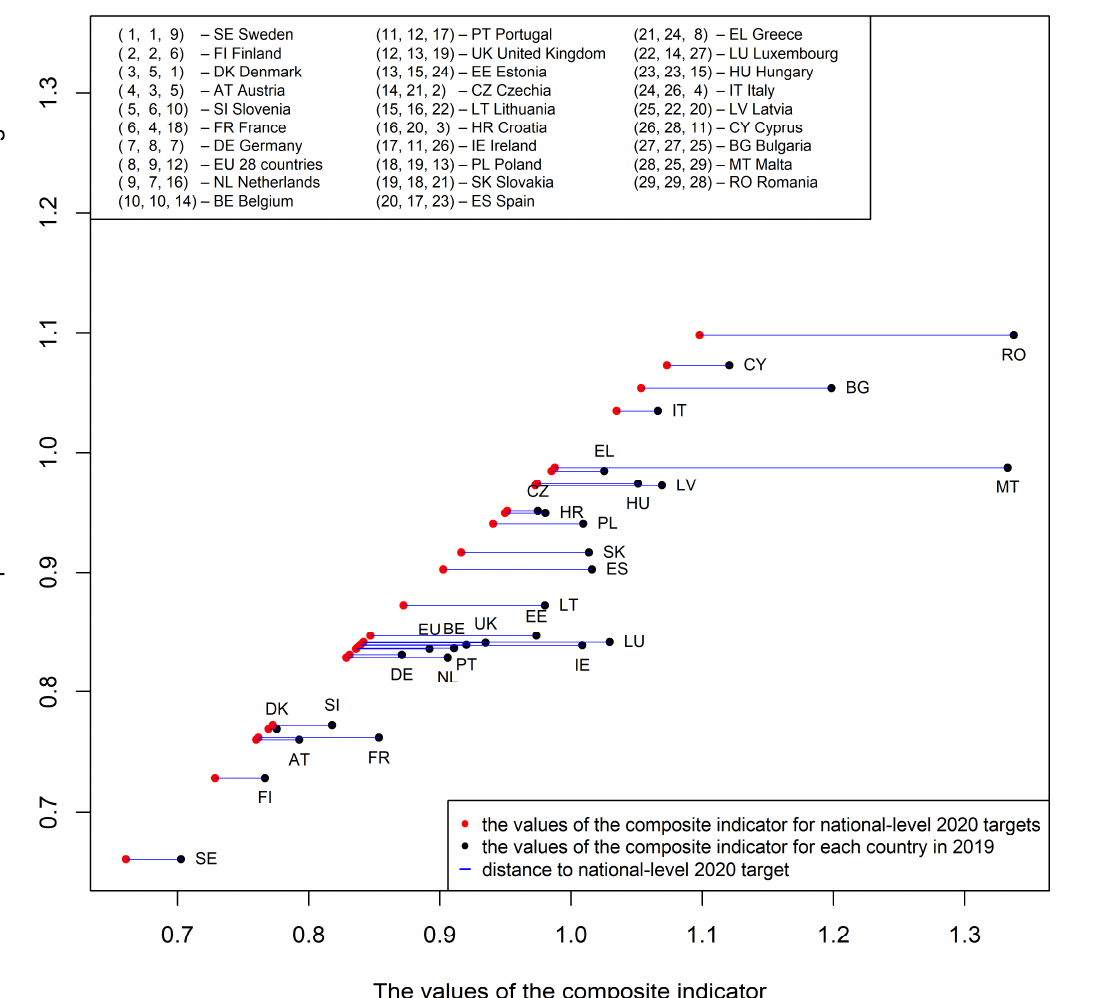
(1, 1, 9)—SE Sweden—values in brackets indicate, respectively, the country position (in this case Sweden) in the ranking based on aggregate measure values for 2019 (1—point marked in black), based on the values of the composite indicator for the national-level 2020 targets of the Strategy target values (1—point marked in red) and the distance values to the national-level 2020 target (9—line segment marked in blue) Figure 3. SM it aggregate measure values for 2019 vs. aggregate measure values defined based on the national-level 2020 targets. Source: authors’ compilation.